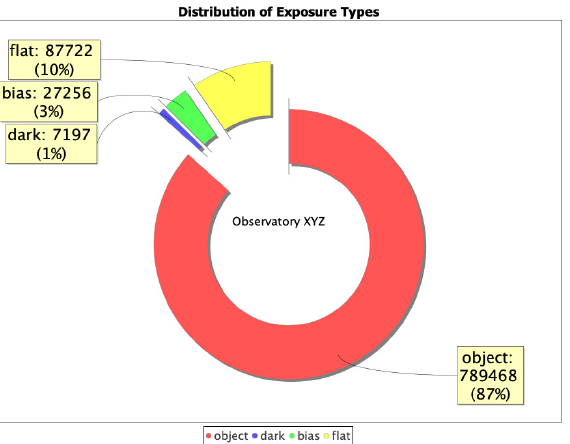
Figure 5. Example ring chart made by Thoth, shown with the ring slices separated from each other for an exploded view. The degree to which the slices can be separated, if at all, is an option set via a slider